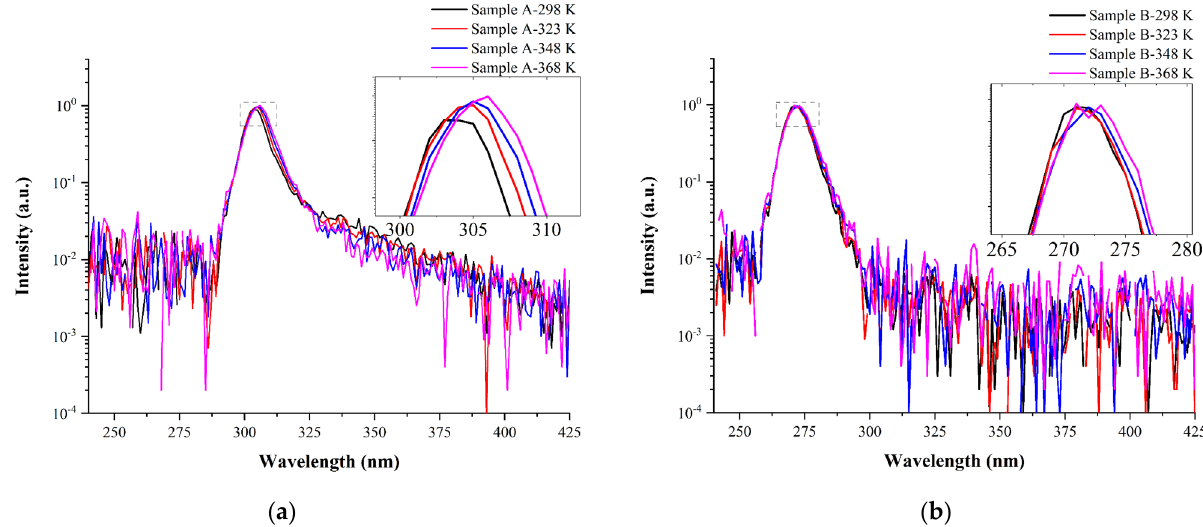
Figure 3. Temperature-dependence of the EL peak wavelengths of ( a ) sample A ( V f = 5.246 V @40 mA) and ( b ) sample B ( V f = 5.530 V @40 mA). The inset is the enlargement of the peak portion.